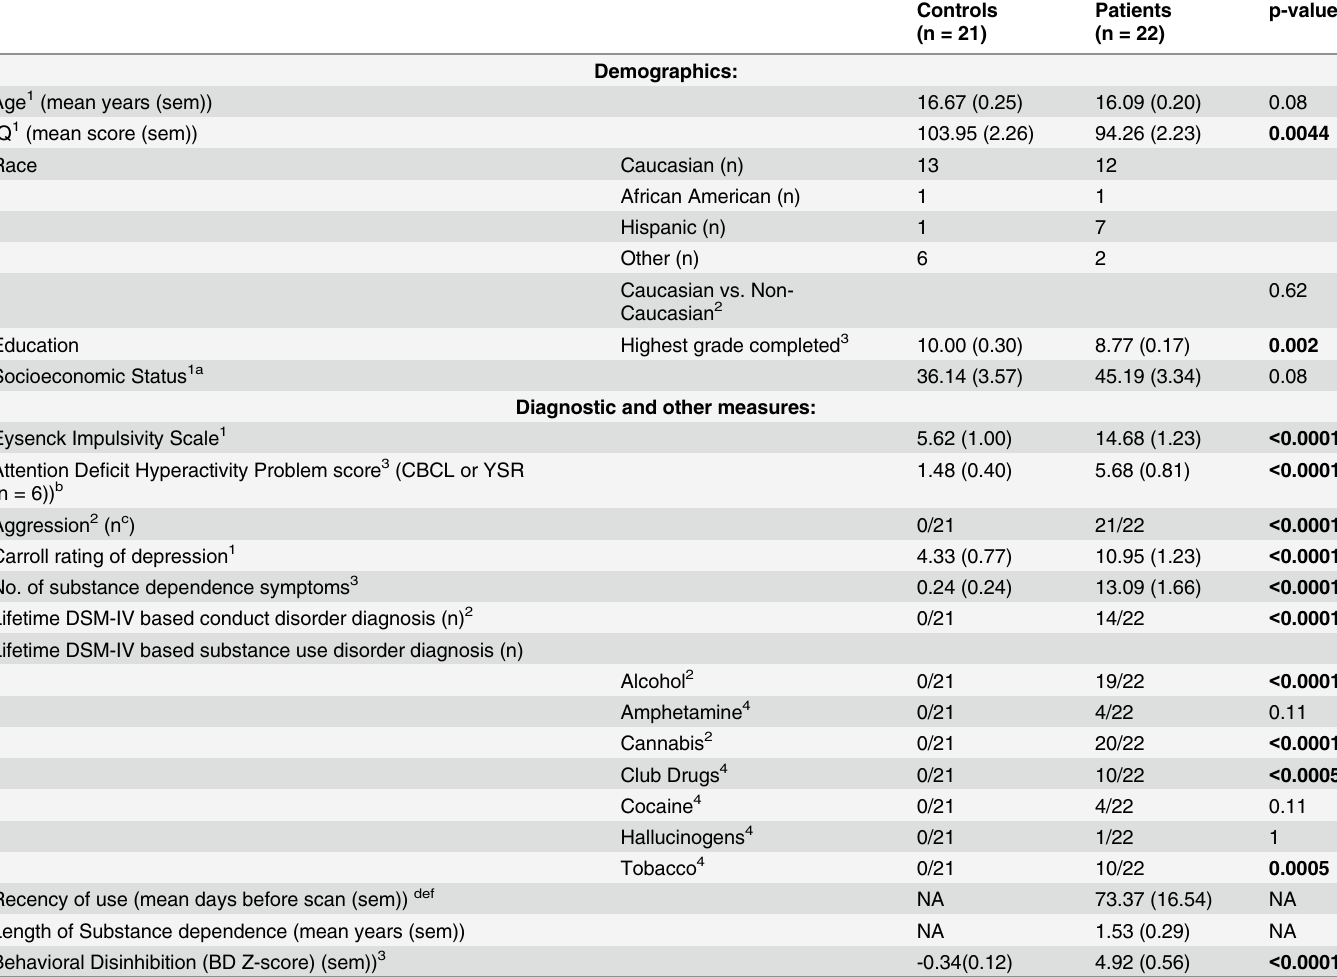
Table 1. Patient-Control Comparisons on Demographics, Diagnostic and Behavioral